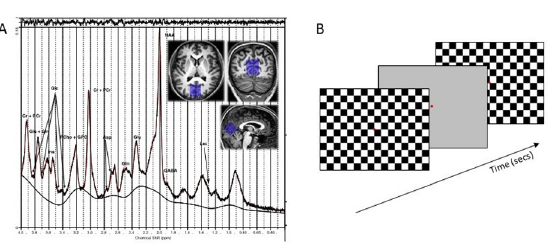
Fig 1. Stimulus example and exemplary spectra from a typical control participant. (A) An example MRS spectrum with approximate peak assignments for known brain metabolites from a 25 year old female participant before stimulation. The FWHM of the peaks were 12 Hz and the SNR was 56, typical of the MRS quality before and after stimulation. The location of the MRS voxel is shown overlaid on the 3D T1 weighted images (inset). (B) Diagram of the flashing checkerboard frames shown during visual cortex